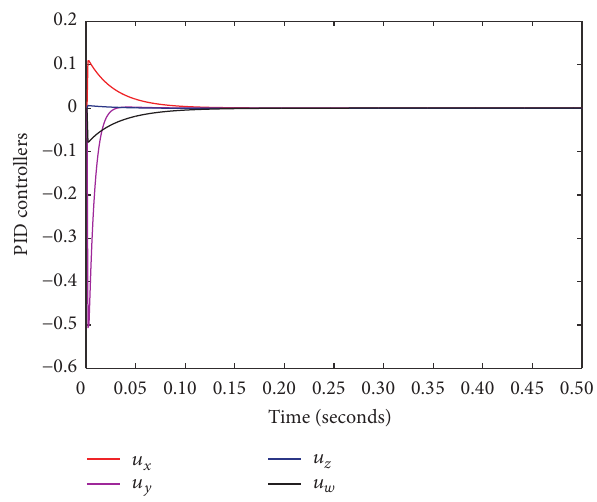
Figure 12: Time history of PID controllers 𝑢 𝑥 , 𝑢 𝑦 , 𝑢 𝑧 , and 𝑢 𝑤 .